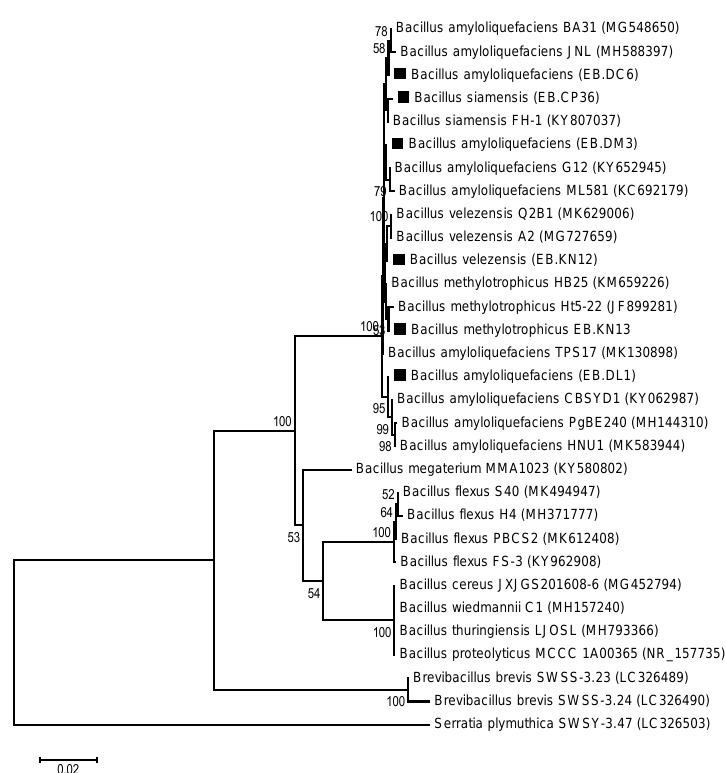
Figure 5. Phylogenic analysis of the endophytic bacteria. The phylogenetic tree was built as per Kimura’s method and created using Mega software version 6.0 after multiple alignments of the data by Clustal W. The numbers at the branches are bootstrap confidence percentages (%).